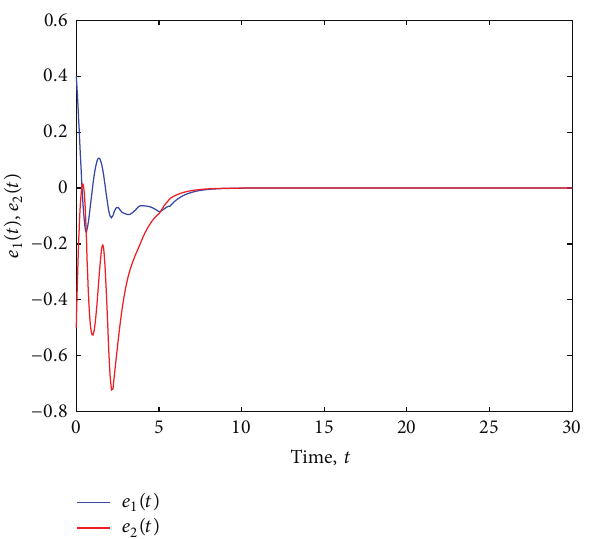
Figure 2: Synchronization error curves of the master system (52) and the slave system (53) with hybrid feedback control